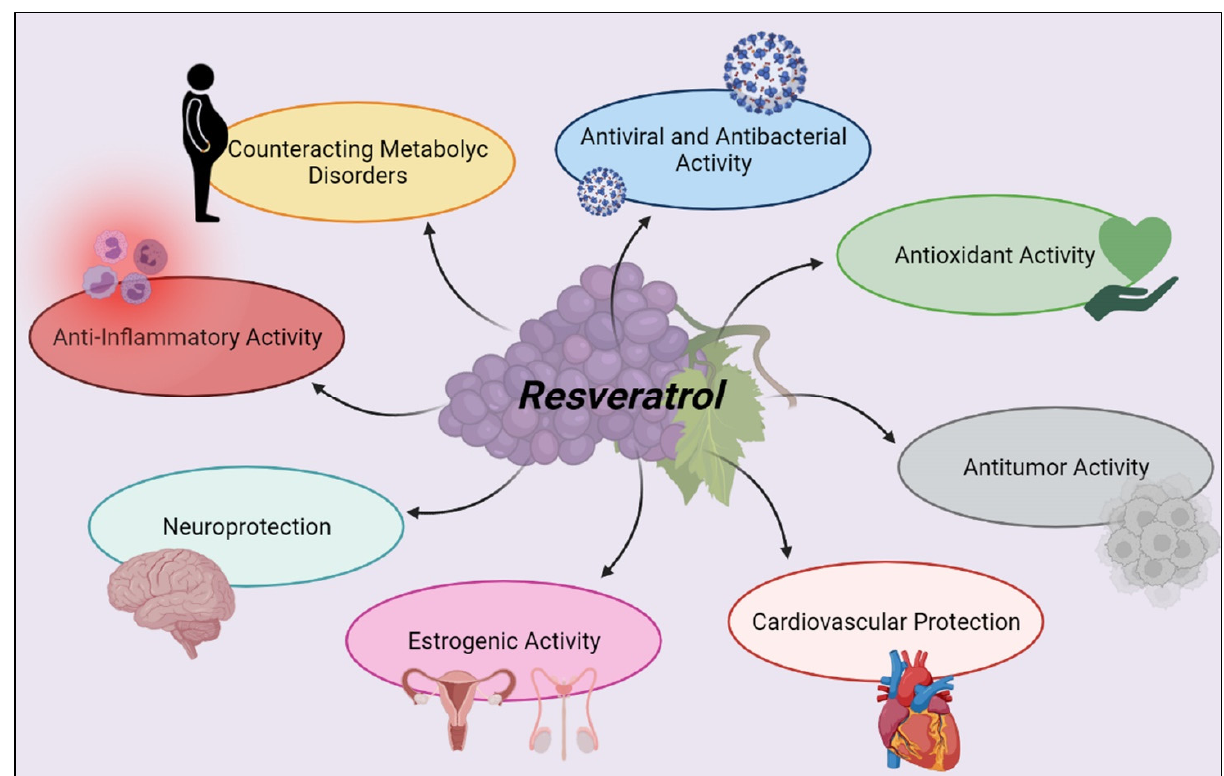
Figure 5. Summarizing scheme of RSV biological activities. Created with BioRender.com (Web